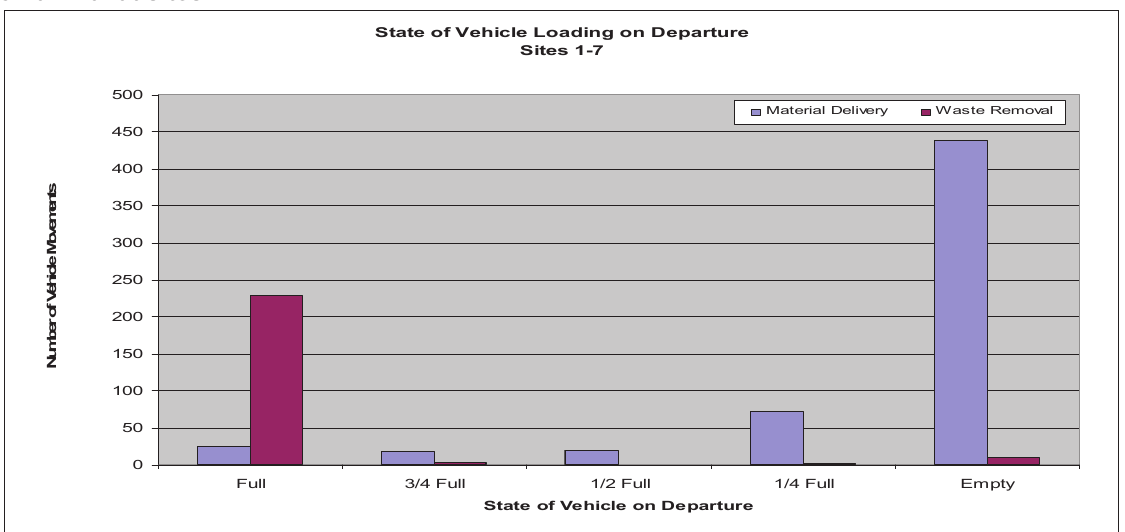
Figure 3 Comparison of loading levels of materials delivery and C&D waste removal vehicles on arrival at sites